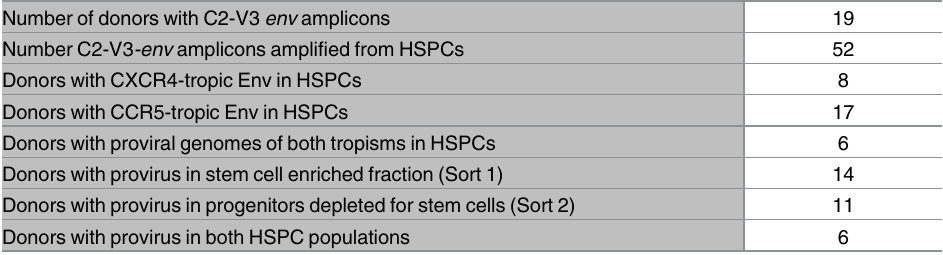
Table 2. Summary of donor env amplicons in Sort 1 and 2